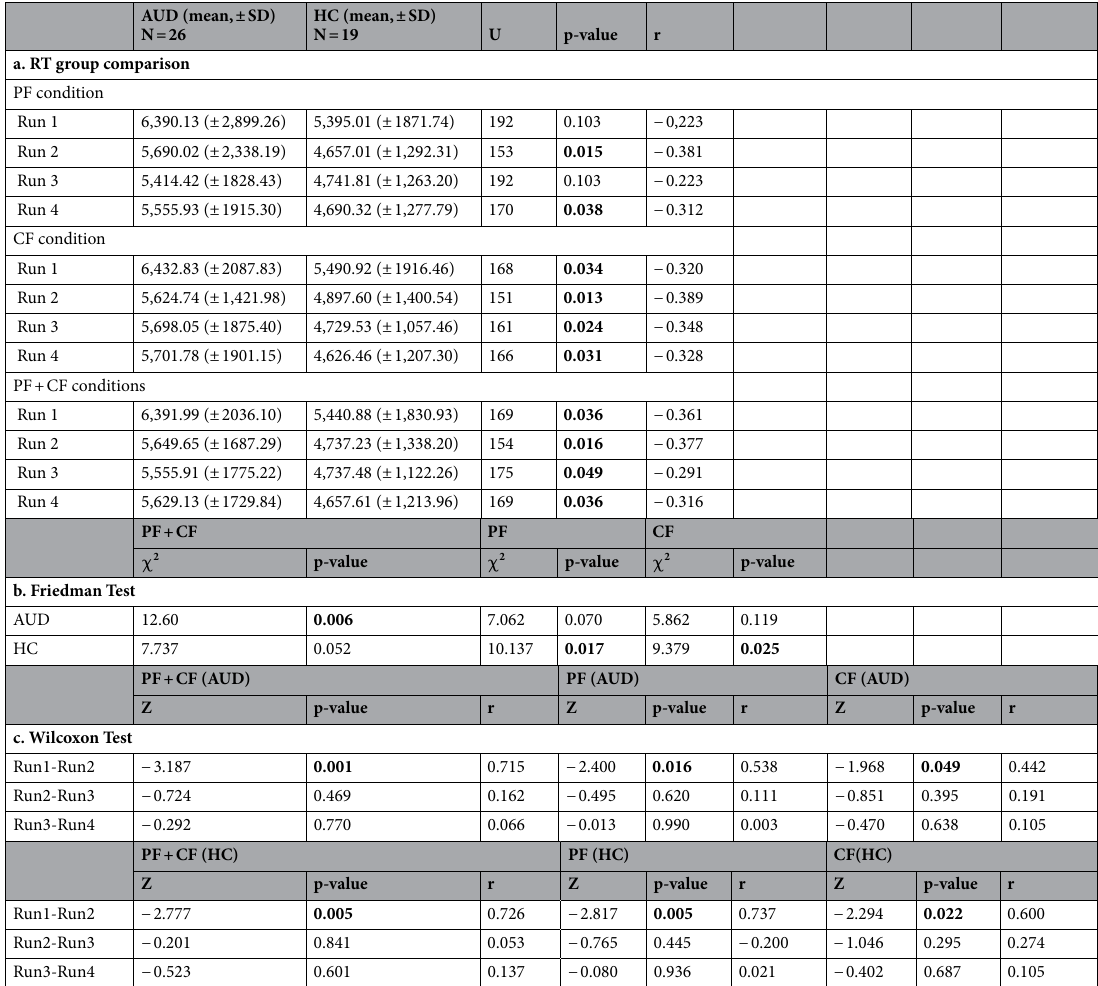
Table 2. Performance analysis. Section (a) reports data on run-specific group differences for partial- and complete-feedback conditions, or both (non-parametric Mann-Whitney U test). Section (b) reports information about RT differences across the 4 experimental runs. Section (c) reports the results of Wilcoxon tests aimed to unveil learning abilities. PF=partial feedback; CF=complete feedback; AUD=AUD patients; HC=healthy controls; SD=standard deviation; χ 2 = Friedman test; Z=Wilcoxon Test; r=Rank biserial correlation. Bold values denote statistical significance at the p < 0.05